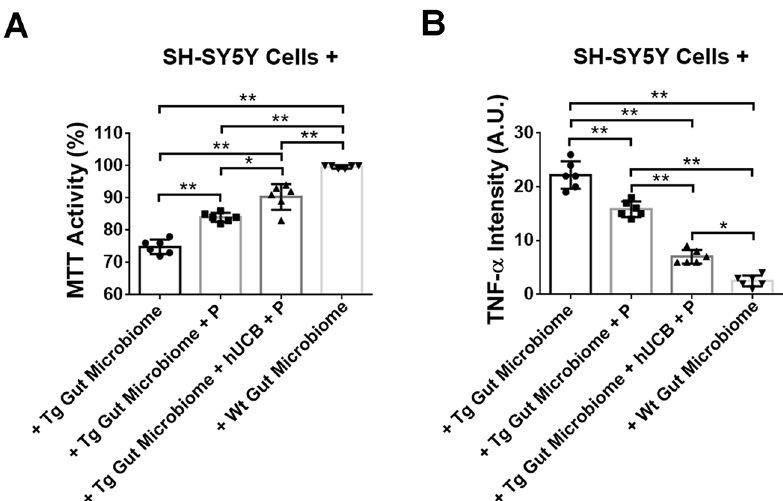
Fig. 5 Probing the gut-brain axis via cell culture mechanistic paradigm. MTT activity assay revealed cultured SH-SY5Y cells under Wt gut homogenates displayed robust cell viability ( A ) with only trace levels of TNF- α ( B ). In contrast, exposure of SH-SY5Y cells to Tg gut reduced cell viability by about 25% and increased by about 10-fold TNF- α levels compared to Wt-exposed SH-SY5Y cells (*** p < 0.05, **** p < 0.01). Tg gut + P or Tg gut + hUCB + P still also showed lower cell viability and higher TNF- α expression compared to Wt gut-exposed SH-SY5Y cells (*** p < 0.05, **** p < 0.01), but they increased cell viability by about 13 – 20% and decreased TNF- α by about 27 – 68% compared to Tg gut- exposed SH-SY5Y cells (*** p < 0.05, **** p < 0.01), with the Tg gut + hUCB + P more effectively sequestering neurodegeneration and in fl ammation than Tg gut + P (*** p < 0.05, **** p <